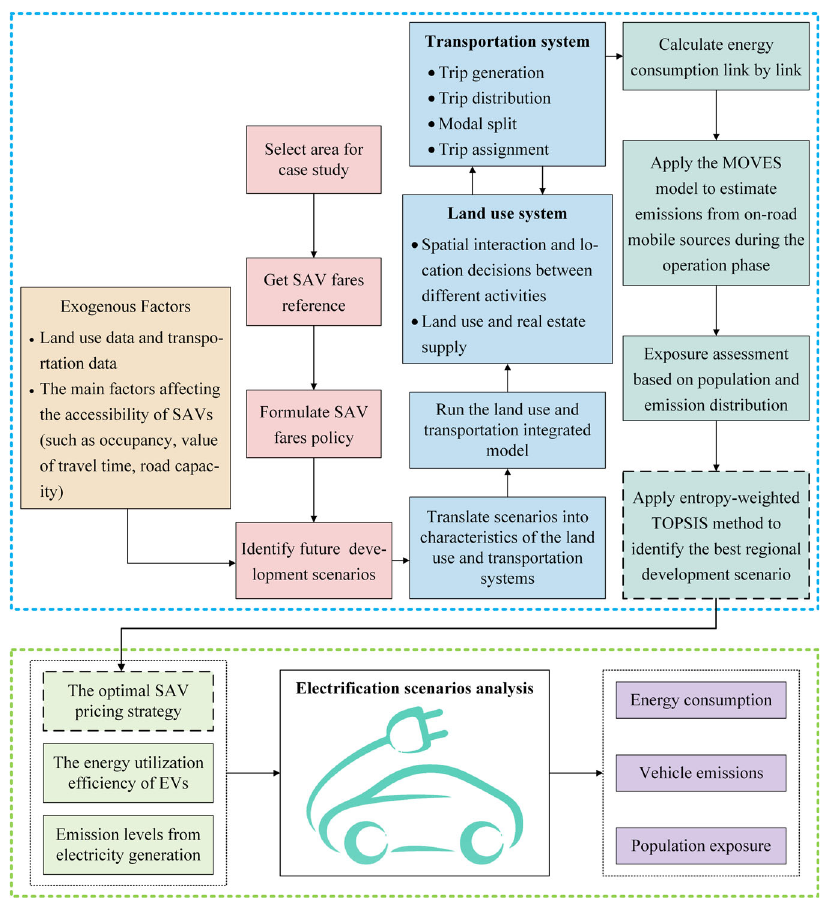
Fig. 6 A conceptual overview of the sequential modeling processes. A sequential model is applied to assess the energy and environmental impacts of different regional development scenarios quantitatively. The model incorporates the quasi-dynamic land use and transport integrated model, vehicle emission model, entropy-weighted TOPSIS method, and electri fi cation scenarios